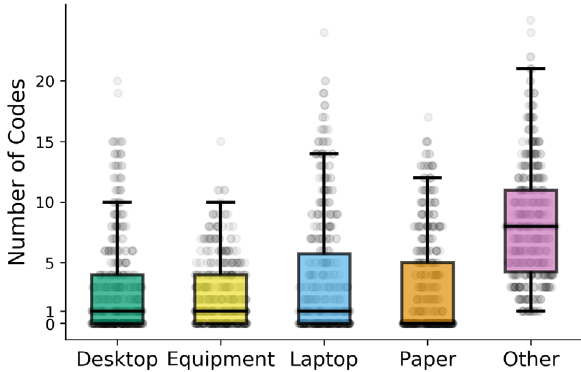
FIG. 2. Box plots of raw data revealing the highly non- Gaussian nature of the code distributions. Each faded point is the accumulated codes for a student in a lab period for a particular category (the horizontal spread of the points is just to visualize all the points), and so darker regions represent more total codes of that value (with the darkest regions near zero). Note that the median for all codes except other is less than or equal to one, reflecting the fact that over half of students were observed engaging in that behavior once or less than once. This, combined with the fact that there are a large number of outliers, is an indication that students either engage in a particular activity a lot or not at